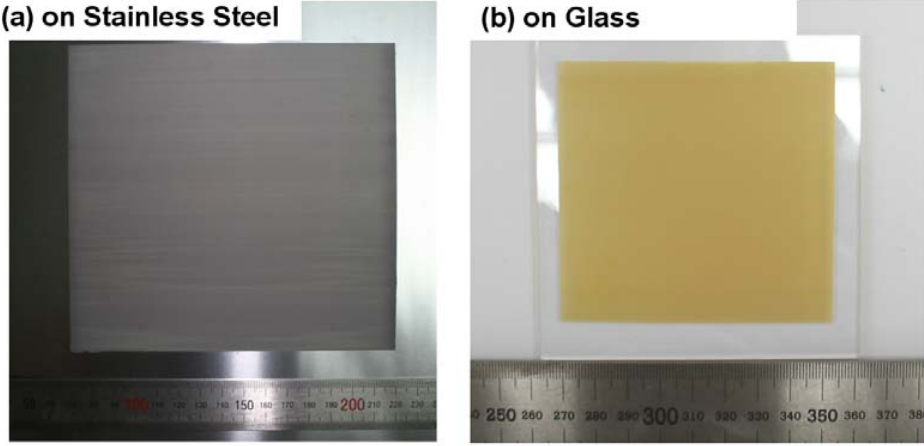
Figure 11. Large area piezoelectric 10  m-thick films by AD. (a) 150 × 150 mm 2 on stainless steel and (b) on 100 × 100 mm 2